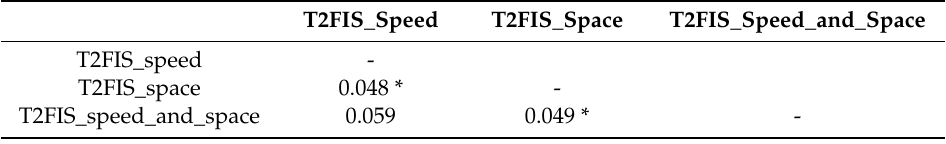
Table 5. The di ff erence between cumulative deviation (CD) values per T2FIS tested by paired t -test.